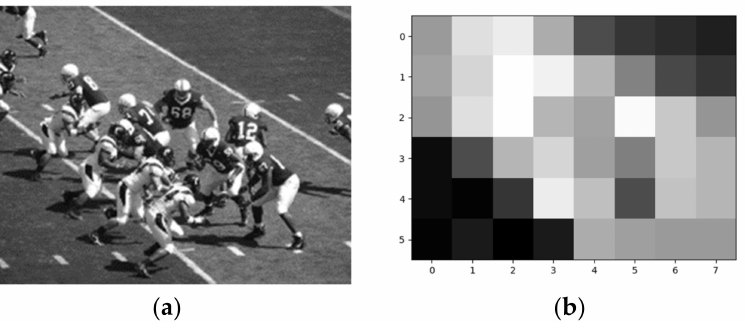
Figure 2. ( a ) The sample image (256 × 192 pixels). ( b ) A downscaled version of the sample image (8 × 6